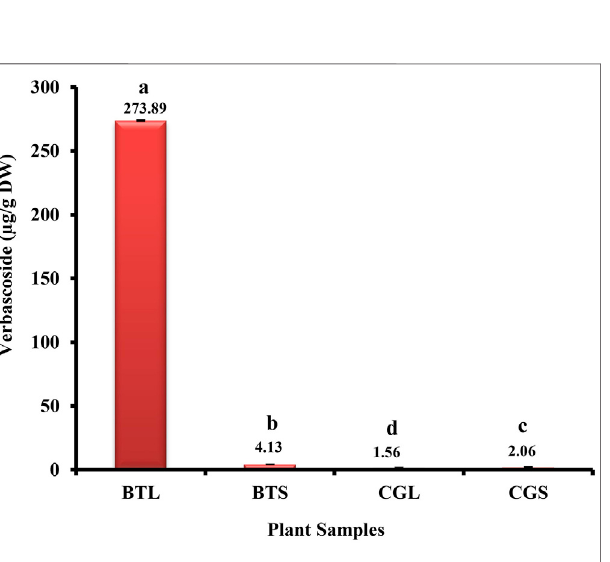
FIGURE 4 | RP-HPLC chromatogram of standard (A) and verbascoside from the leaves of B. terminalis (B).